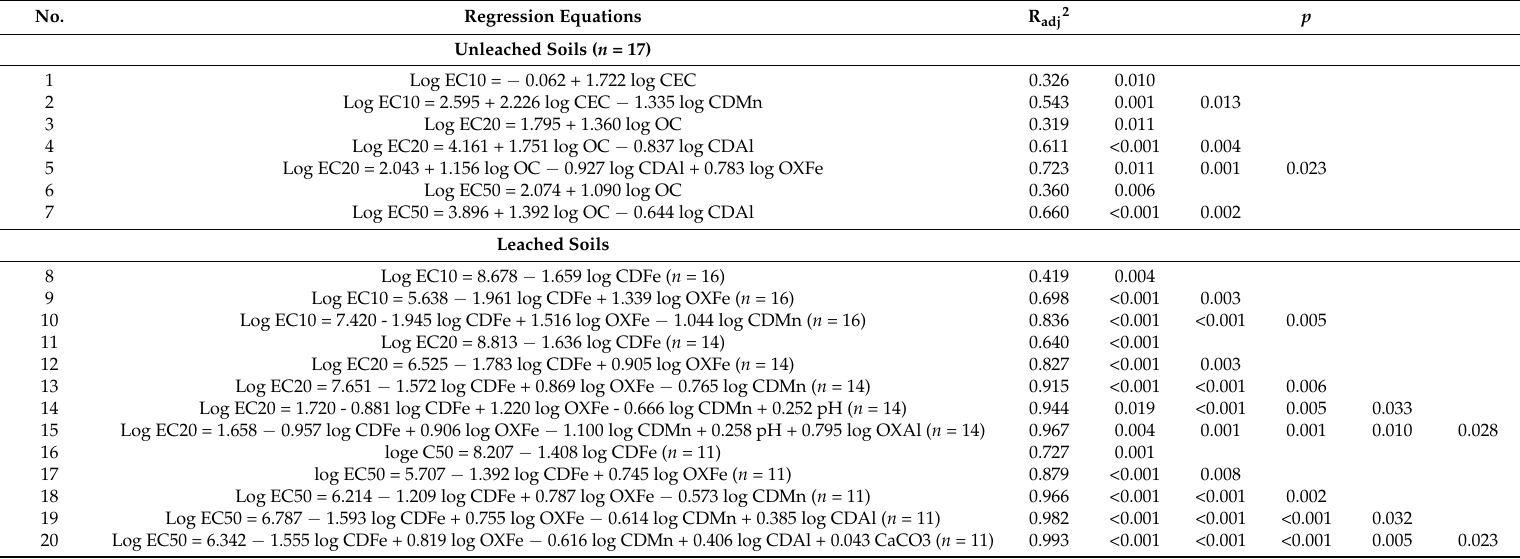
R adj2 = adjusted coefficient of determination; p = significance level of the factors included in the regression